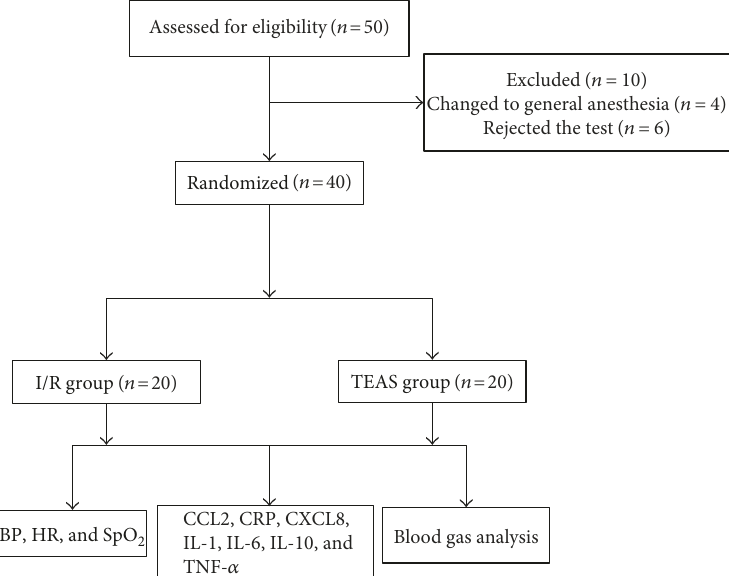
Figure 1: Flowchart of study design. I/R: ischemia-reperfusion, TEAS: transcutaneous electrical acupoint stimulation, BP: noninvasive blood pressure, HR: heart rate, SpO : capillary oxygen saturation, CCL2: C-C motif chemokine ligand 2, CRP: C-reactive protein, CXCL8: C-X-C 2 motif chemokine ligand 8, IL-1: interleukin-1, IL-6: interleukin-6, IL-10: interleukin-10, and TNF- α : tumor necrosis factor- α